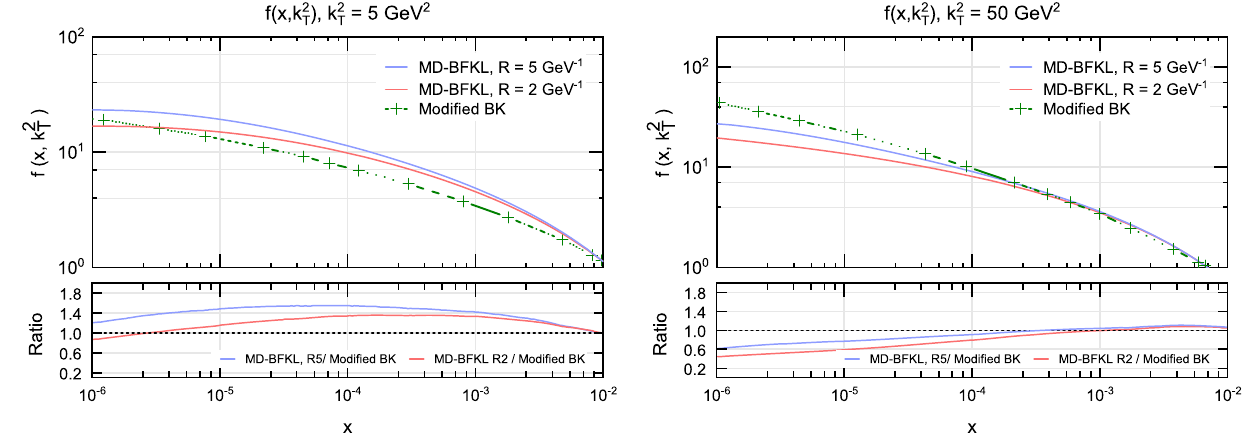
Fig. 5 Q 2 evolution of collinear gluon distribution xg ( x , Q 2 ) . Our results of KC improved MD-BFKL are shown for conventional R = 5 GeV − 1 (gluons are distributed throughout the nucleus) and R =